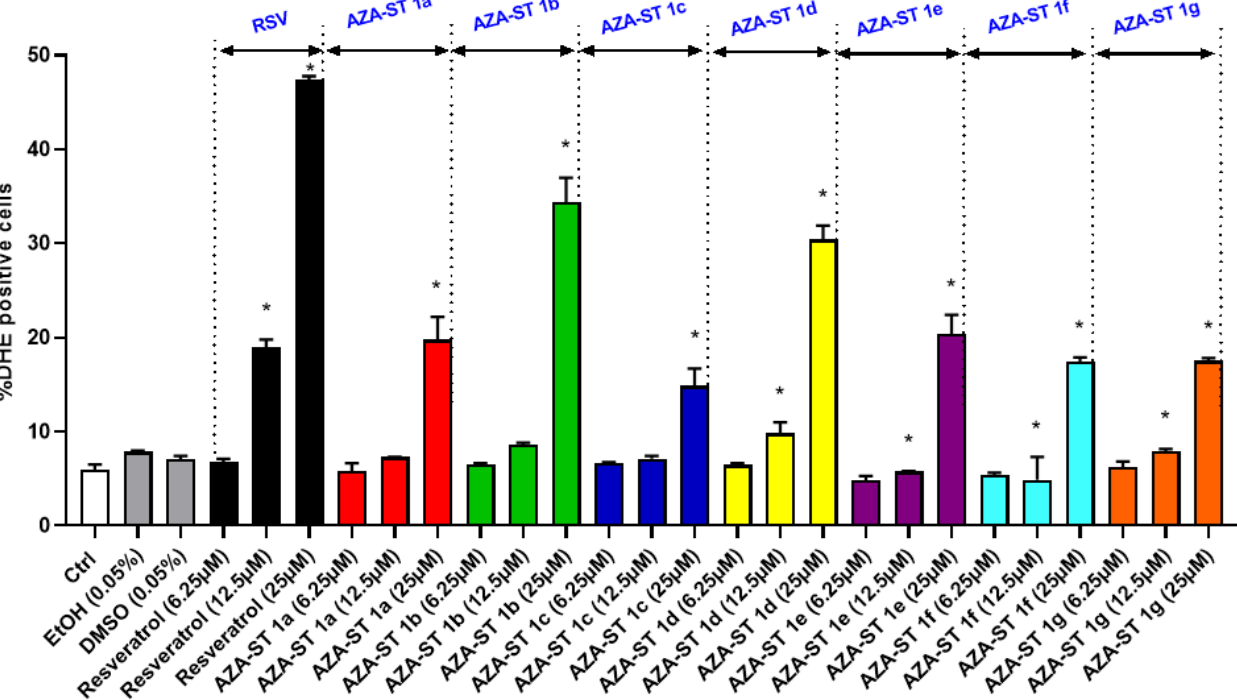
Figure 6. Flow cytometric evaluation of the effects of AZA-ST 1a–g and resveratrol on ROS overproduction in whole cells by staining with dihydroethidium (DHE). N2a cells were incubated for 24 h with or without AZA-ST 1a–g or resveratrol (RSV; trans -resveratrol) at concentrations inclosing the IC50s (6.25, 12.5 and 25 µM). Vehicles (Ethanol (EtOH) for RSV; DMSO for AZA-ST) [15]: Ethanol (EtOH; 0.05%) and DMSO (0.05%); the highest concentrations of vehicles were only analyzed. The data are the mean ± standard deviation (SD) of three independent experiments performed in triplicate. The comparison of the data was performed with an ANOVA test followed by a Bonferroni test. (*): p ≤ 0.05 was considered statistically significant.